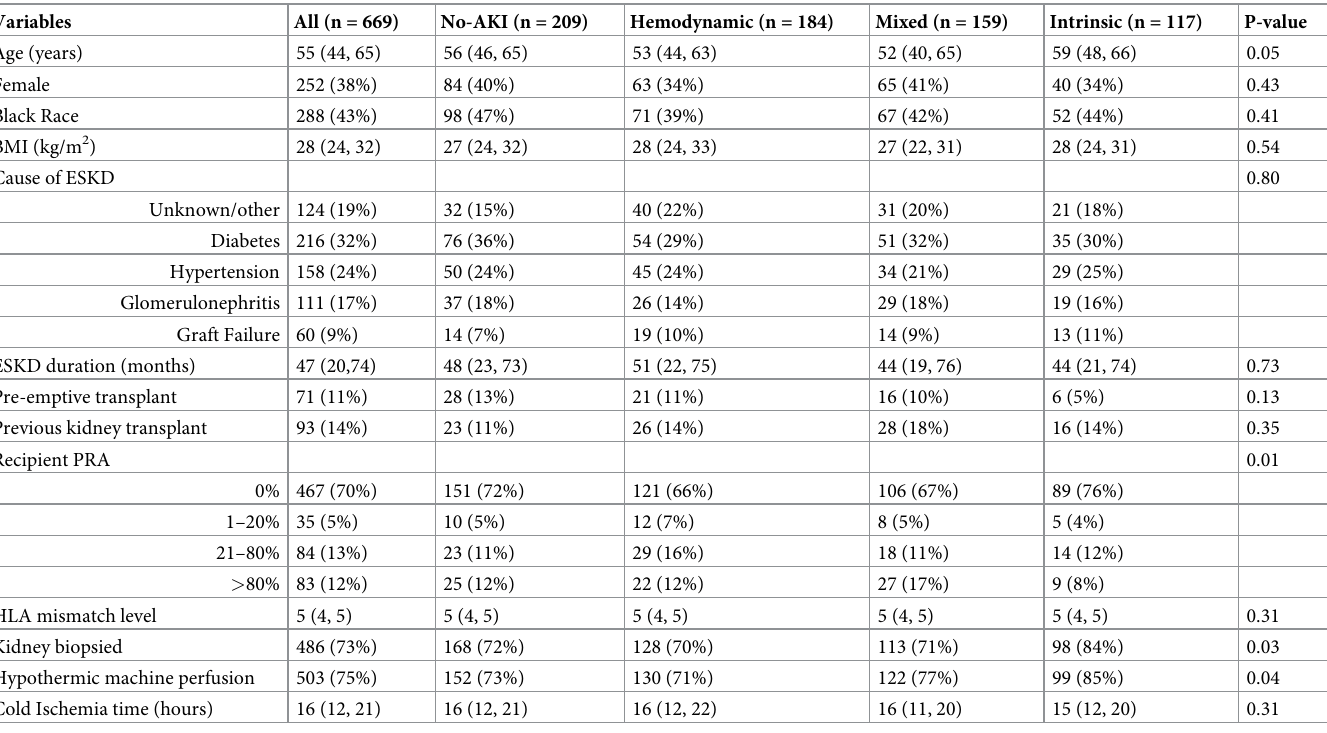
Table 2. Recipient and transport characteristics by AKI